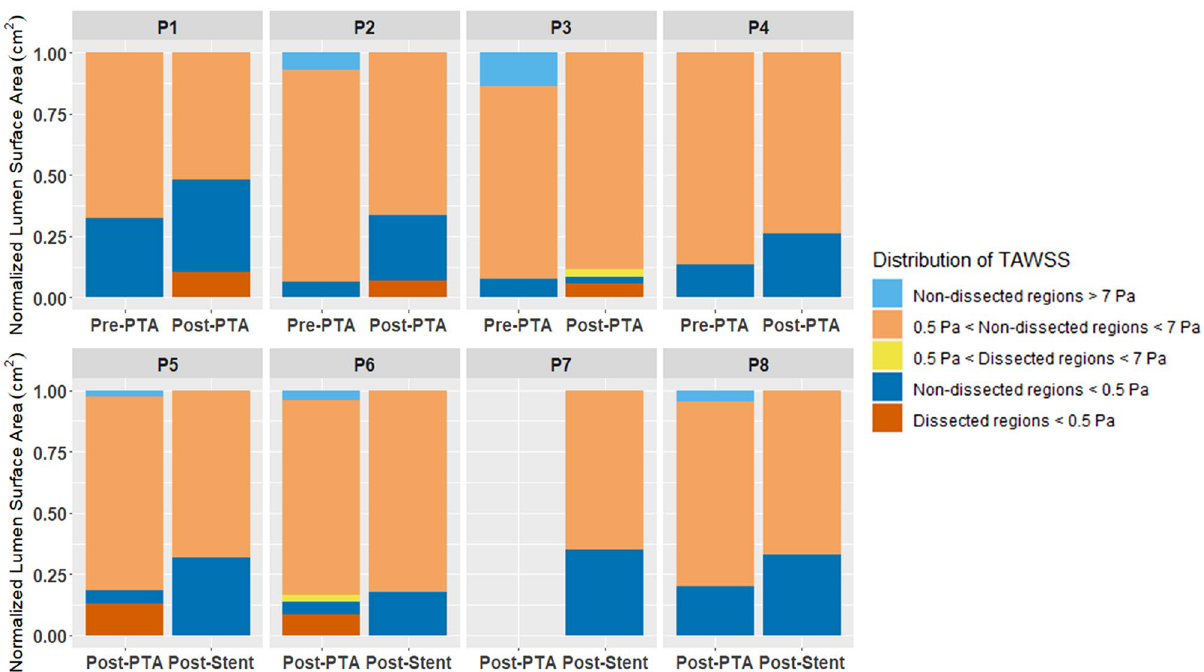
Figure 2. The normalized distribution of adverse hemodynamics (TAWSS < 0.5 Pa; TAWSS > 7 Pa) and normal flow behavior at the lumen surface for different segments of the artery. (Generated by R 3.5.0, https:// www.r- proje ct.